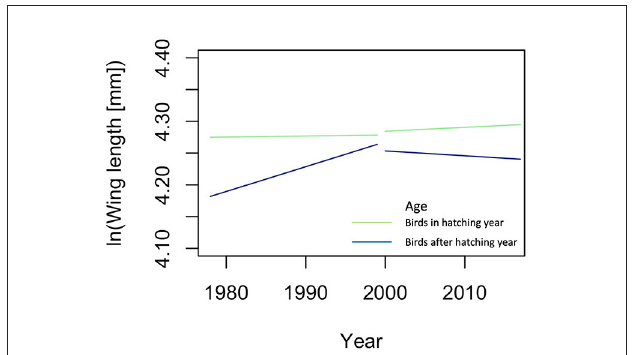
FIGURE2 Results of the analysis of the change in wing length of North American migration birds ignoring taxonomic information; the lines are the predicted changes in Wing length. Green lines are hatchlings, blue lines older birds. Predictions were made with linear models, lm() in R version 4.0.3 [56], with age, year, period and all their interactions as independent variables. A description of this analysis is given in Appendix 2. To draw the graphs, the variable Sex and random effect variable year were ignored, in comparison with the model in